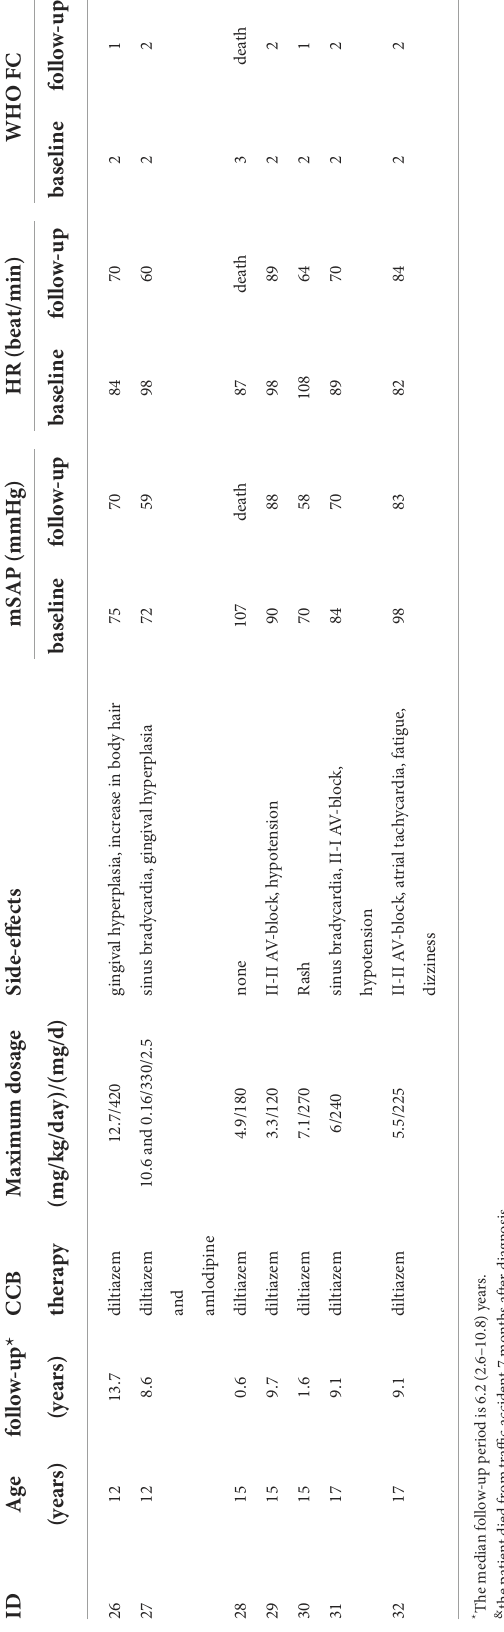
TABLE 3 Long-term adverse effects of calcium channel blockers.